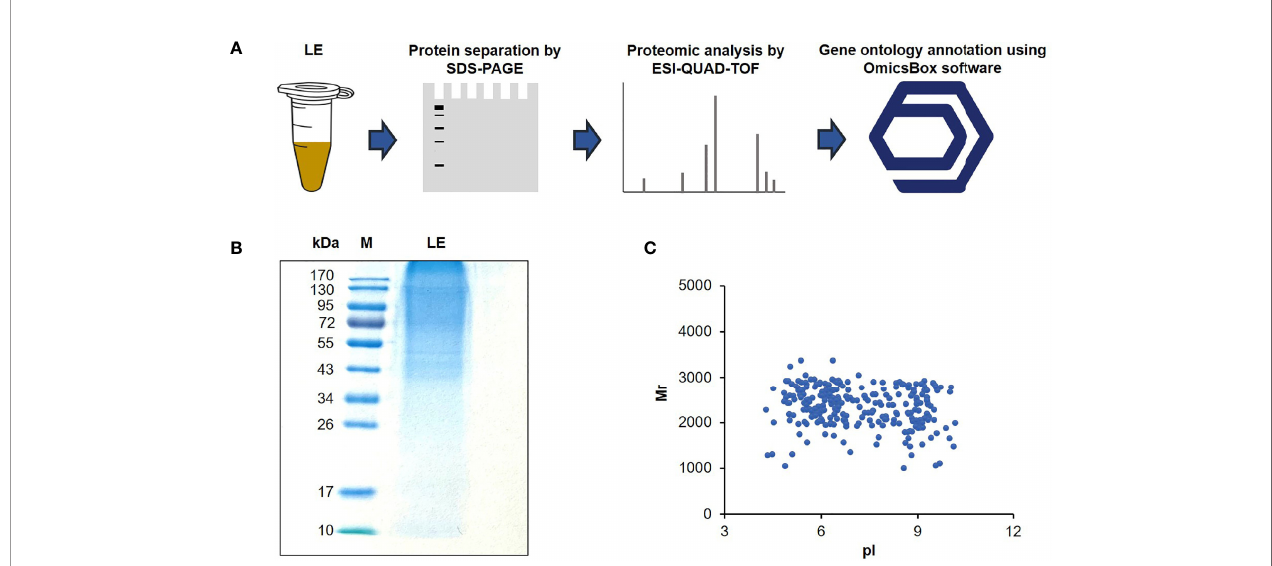
FIGURE 3 | Protein content of the T. spiralis infective larval extract (LE). (A) Flow diagram of proteomic analysis of LE using electrospray ionization quadrupole ion mobility time-of- fl ight mass spectrometry (ESI-QUAD-TOF) and OmicsBox software. (B) Protein patterns of the LEs on a 12% gel after SDS-PAGE and CBB staining. M, protein marker; numbers on the left are protein molecular masses in kDa. (C) Two-dimensional protein relative molecular masses (Mr) and the pH value at which the total charge on each protein was zero